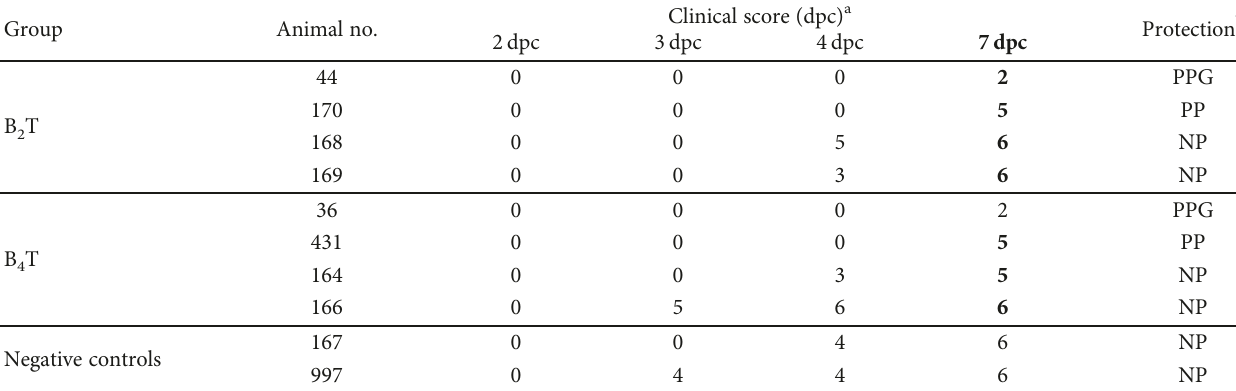
Table 3: Clinical scores of vaccinated cattle after challenge. Group Animal